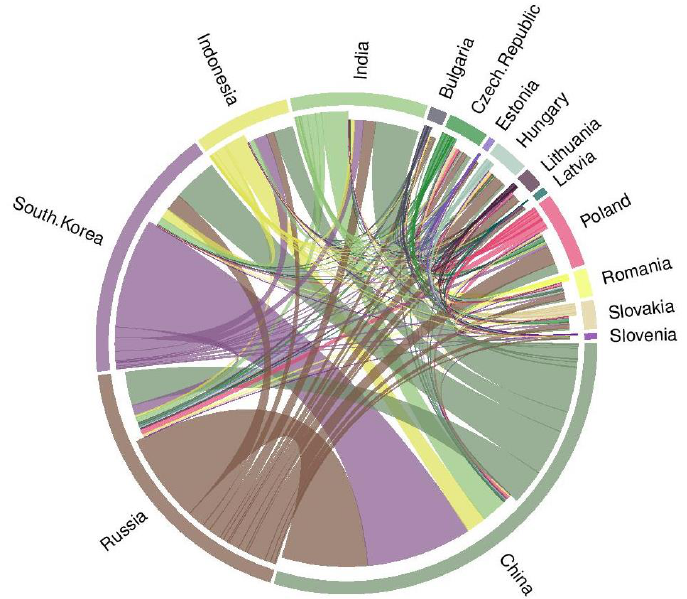
Figure 2. Interlinked relations of energy use between the fifteen economies in trade (excluding RoW).